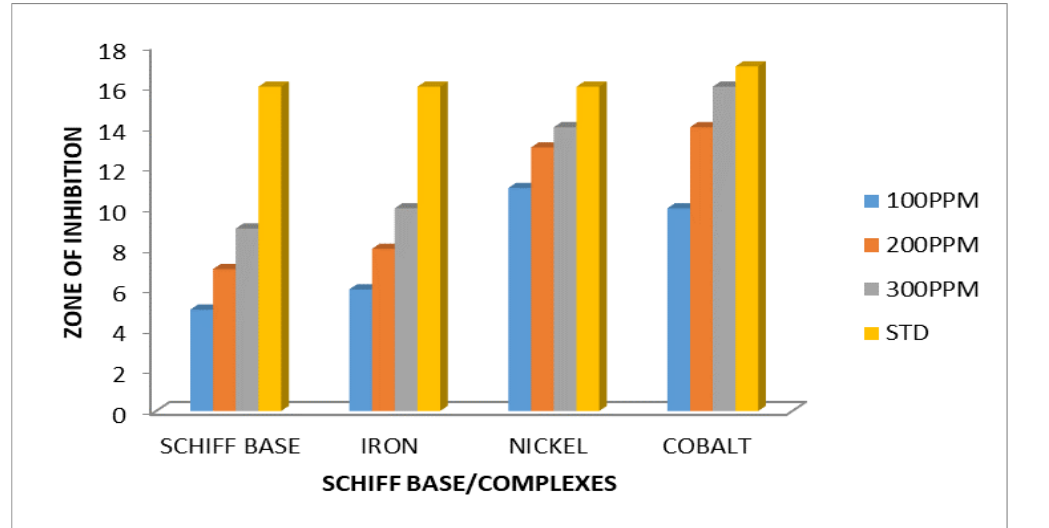
Figure 1. Sensitivity test for of and metal (II) complexes against clinical isolate ( Staphylococcus.aureus ) using well diffusion